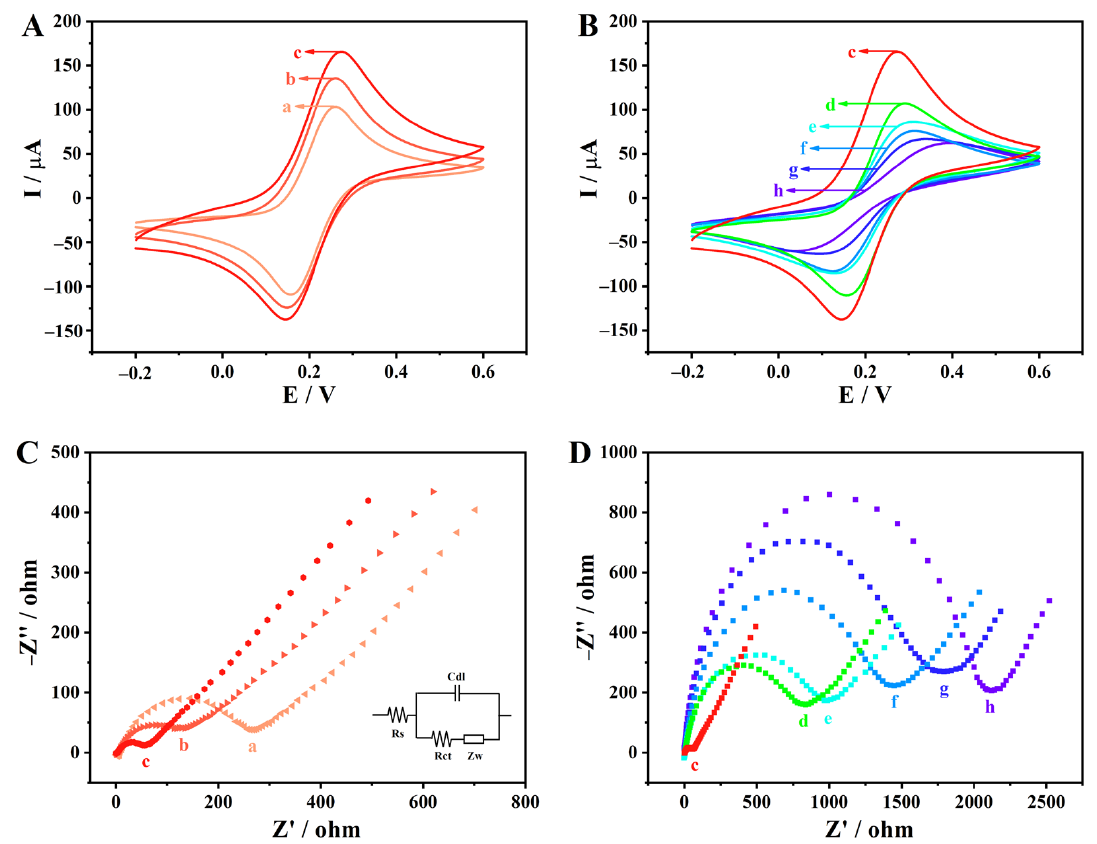
Figure 3. CV ( A , B ) and EIS ( C , D ) of different electrodes: (a) GCE; (b) VS 2 /GCE; (c) AuNPs/VS 2 /GCE; (d) arch DNA/AuNPs/VS 2 /GCE; (e) MCH/arch DNA/AuNPs/VS 2 /GCE; (f) cruciform DNA/MCH/arch DNA/AuNPs/VS 2 /GCE; (g) target cell/cruciform DNA/MCH/arch DNA/AuNPs/VS 2 /GCE; (h) HRP/target cell/cruciform DNA/MCH/arch DNA/AuNPs/VS 2 /GCE. The inner illustration of ( C ) is the corresponding equivalent circuit diagram of the reaction system. Rct, Rs, Zw and Cdl in the circuit represent charge transfer resistance, solution resistance, Warburg impedance and electric double layer capacitance, respectively. Electrolyte: 0.1 M KCl containing 5 mM [Fe(CN) 6 ] 3 − /4 − .